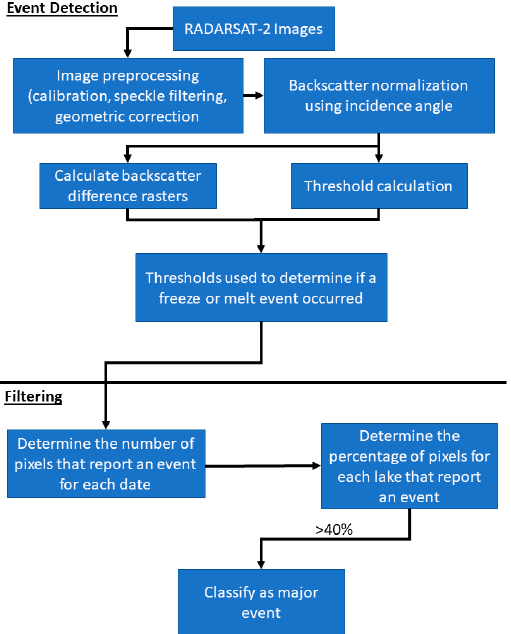
Figure 5. Outline of the method used to determine the lake ice events from 2008 to 2017 for Central Ontario.